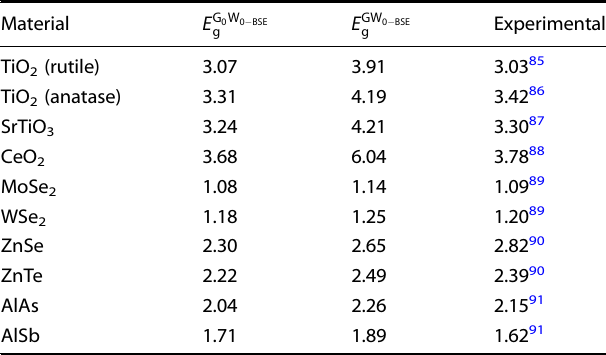
for light polarization along the x ( k ^ a ), y ( k axes, namely α x , α y , and α z . int int int α